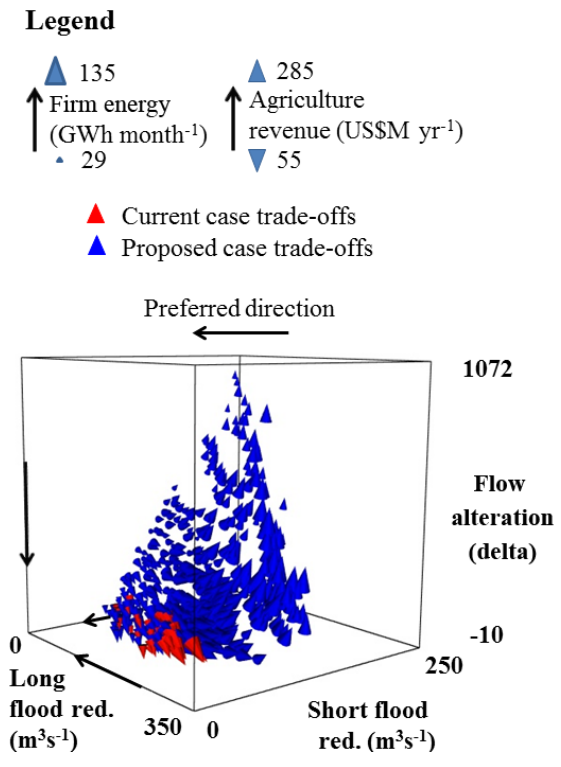
Figure 6. Trade-off surface of the combined current and proposed demands cases (blue cones show system performance when irriga- tion schemes can be expanded). Some proposed demands solutions dominate the current demands solutions, reducing their representa- tion on the surface. This figure shows how trade-offs achievable by the best system operating rules change once irrigation investments are